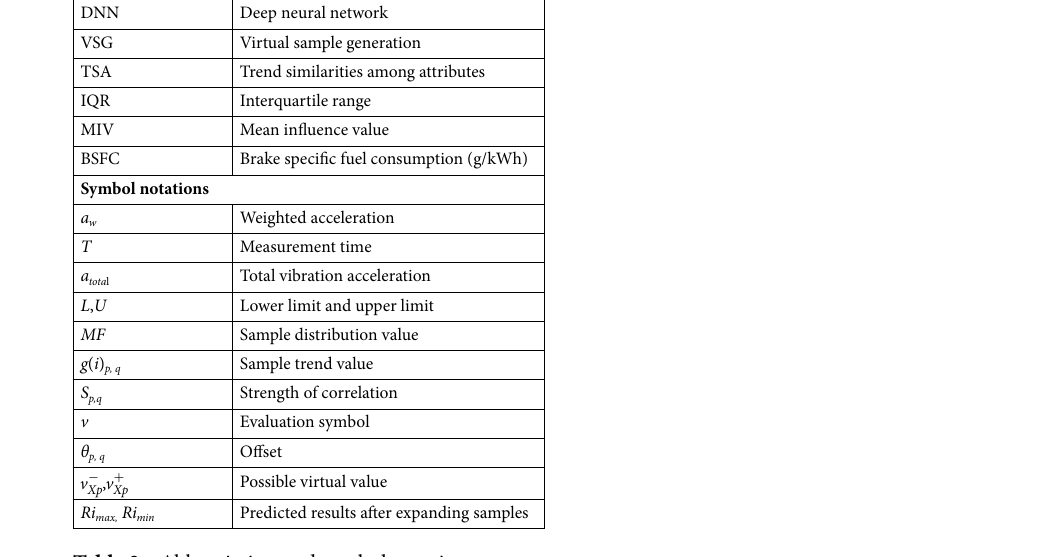
Table 2. Abbreviation and symbol notations.